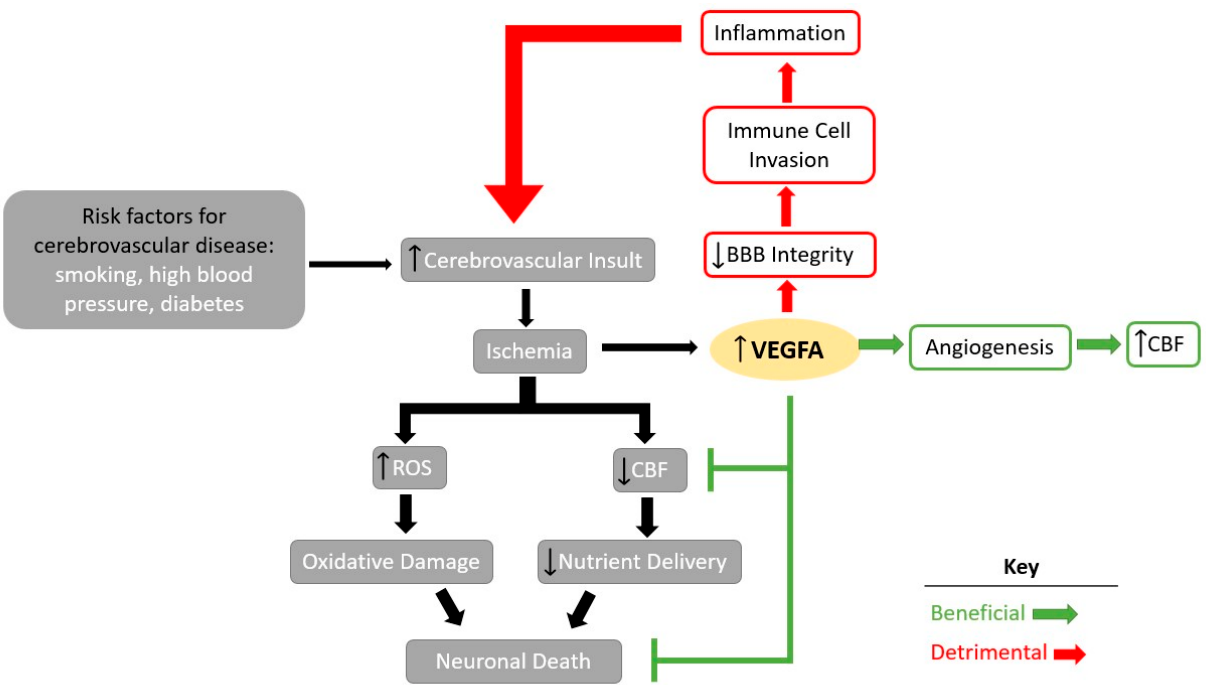
Figure 1. VEGFA signaling in cerebrovascular diseases. Vascular endothelial growth factor A (VEGFA)-induced signaling in cerebrovascular disease can lead to both detrimental (red) and benefi- cial effects (green). BBB: blood–brain barrier. ROS: reactive oxygen species. CBF: cerebral blood fl ow.